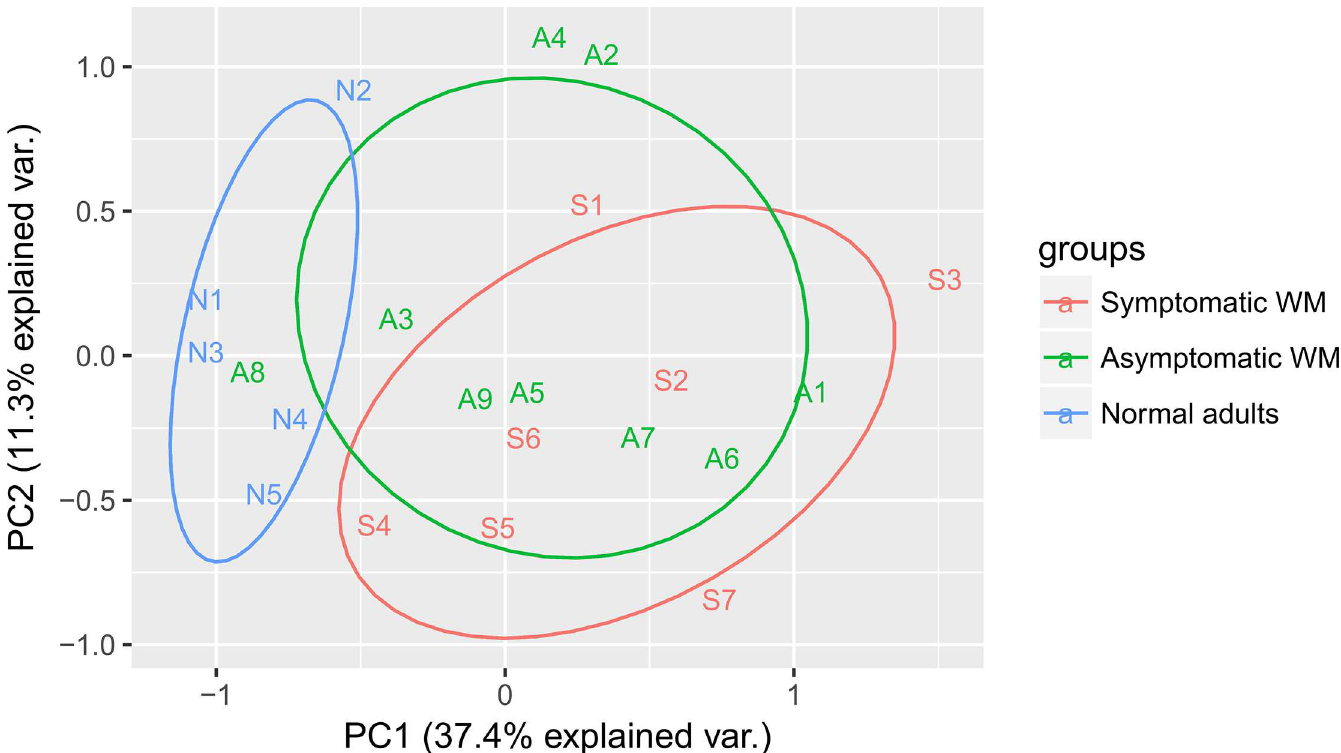
Fig 1. Global exosomal miRNA expression in WM patient groups. Principle Component analysis of TaqMan Array Cards Results representing the variation of exosomal miRNAs’ expression in samples from healthy controls (N1-N5), patients with asymptomatic WM (A1-A9) and patients with symptomatic na ï ve WM (S1-S7).